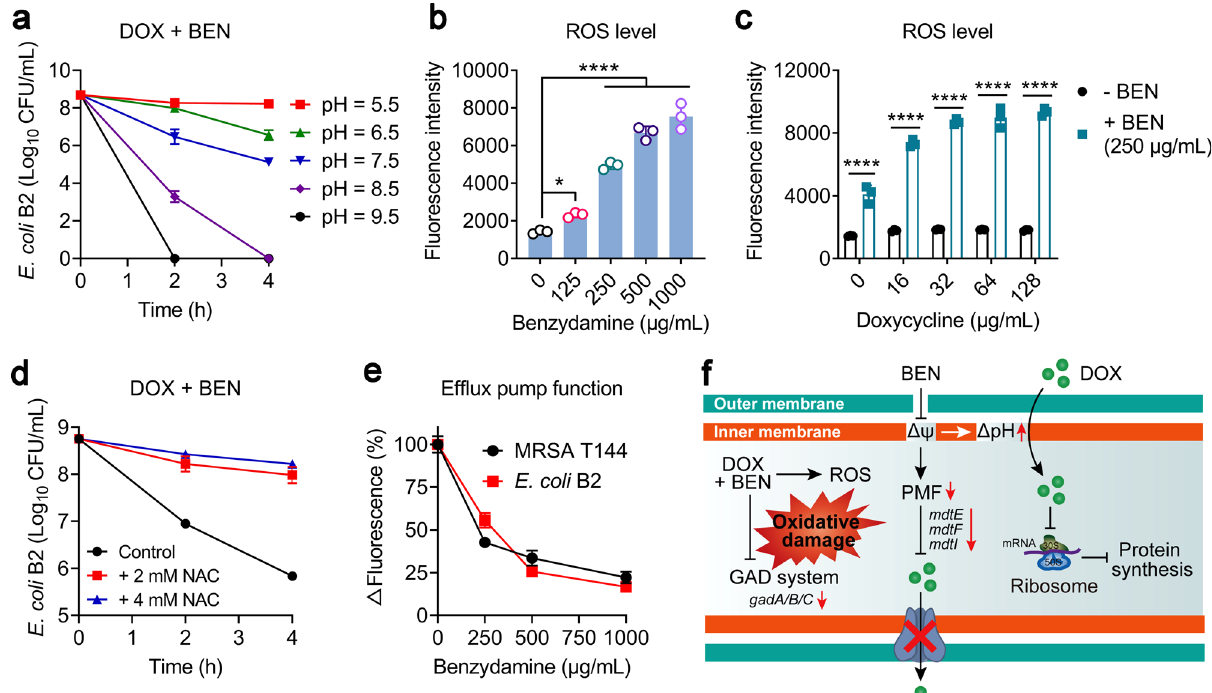
Fig. 6 Benzydamine promotes oxidative damage and inhibits the function of the ef fl ux pump in E. coli . a Time-killing curves of E. coli B2 after treatment with the combination of doxycycline and benzydamine in different pH media from 5.5 to 9.5. b Benzydamine promotes the production of ROS in a dose- dependent manner. c Doxycycline plus benzydamine (250 μ g/mL) shows higher ROS generation compared to doxycycline alone. Fluorescence probe 2 ′ ,7 ′ - dichlorodihydro fl uorescein diacetate (DCFH-DA) was used to monitor the levels of ROS in cells ( λ excitation = 488 nm, λ emission = 525 nm). All data from three biological replicates were presented as mean± SD, and the signi fi cance was determined by non-parametric one-way ANOVA (* P < 0.05, ** P < 0.01, *** P < 0.001, **** P < 0.0001). d The addition of ROS scavenger N -acetylcysteine weakens the potentiation of benzydamine to doxycycline. e Benzydamine drastically impairs the function of ef fl ux pumps in both MRSA T144 and E. coli B2. Rhodamine B ( λ excitation = 540nm, λ emission = 625nm) was used to characterize the activity of ef fl ux pumps in bacteria. f Schematic illustrations of the potentiating mechanisms of benzydamine to tetracyclines in the fi ght against drug-resistant